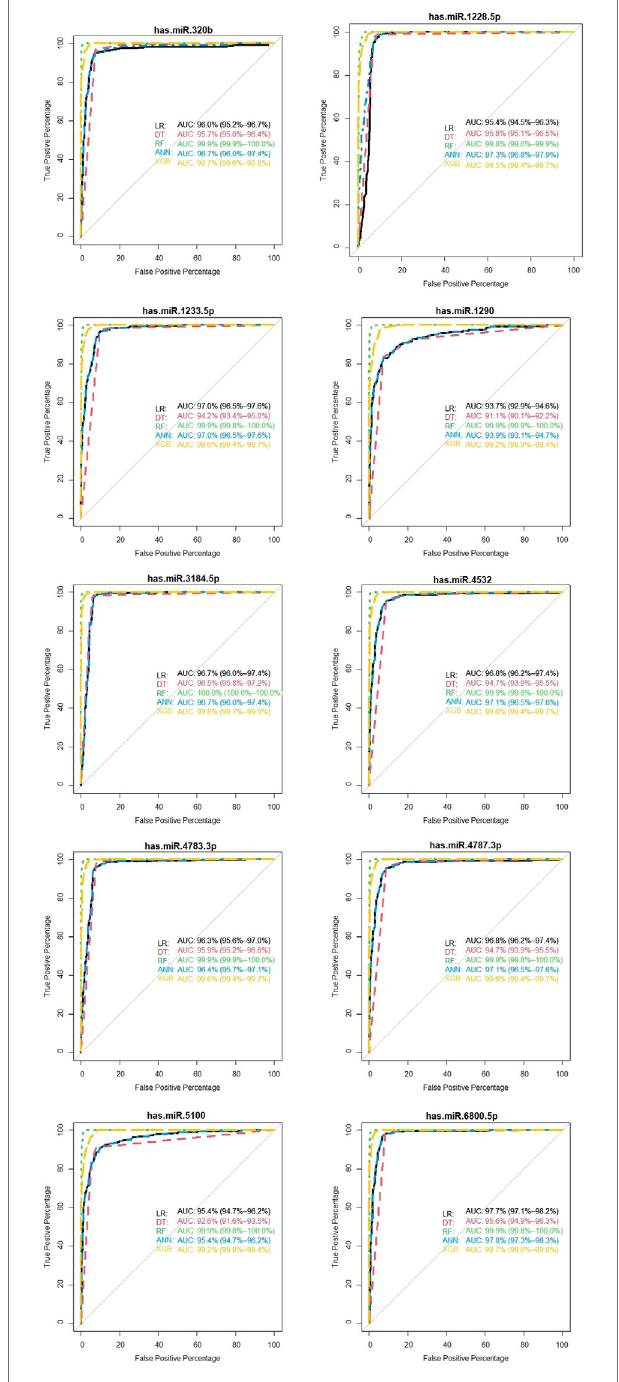
FIGURE 4 | Diagnostic performance of the 10 identi fi ed serum miRNA signatures in the internal (GSE106817) data.